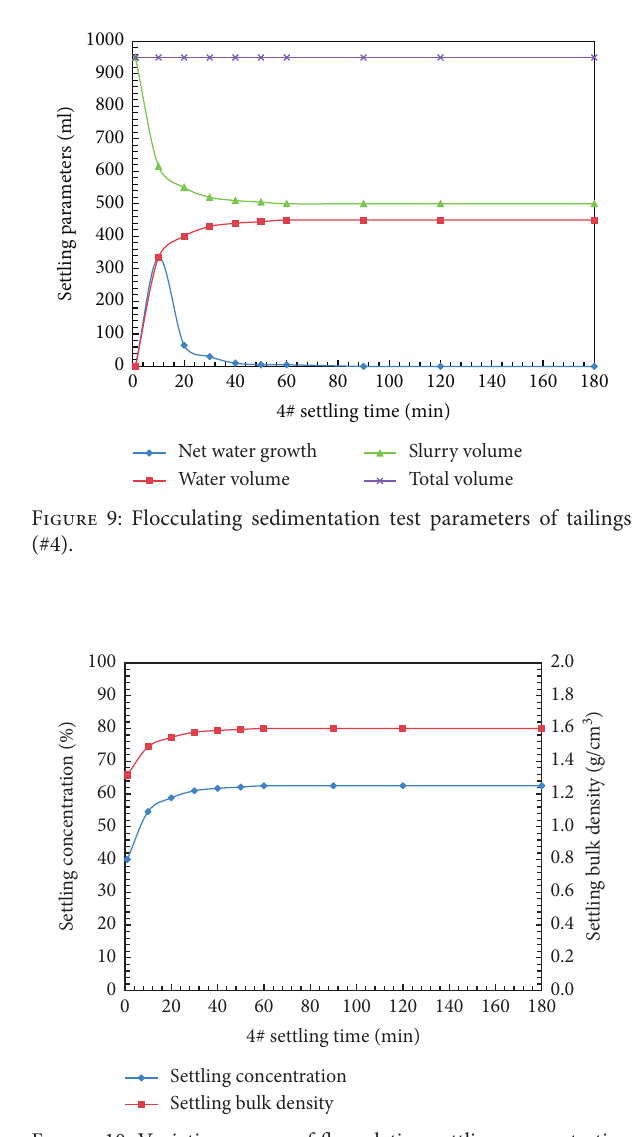
Figure 10: Variation curves of flocculation settling concentration and bulk density (#4).